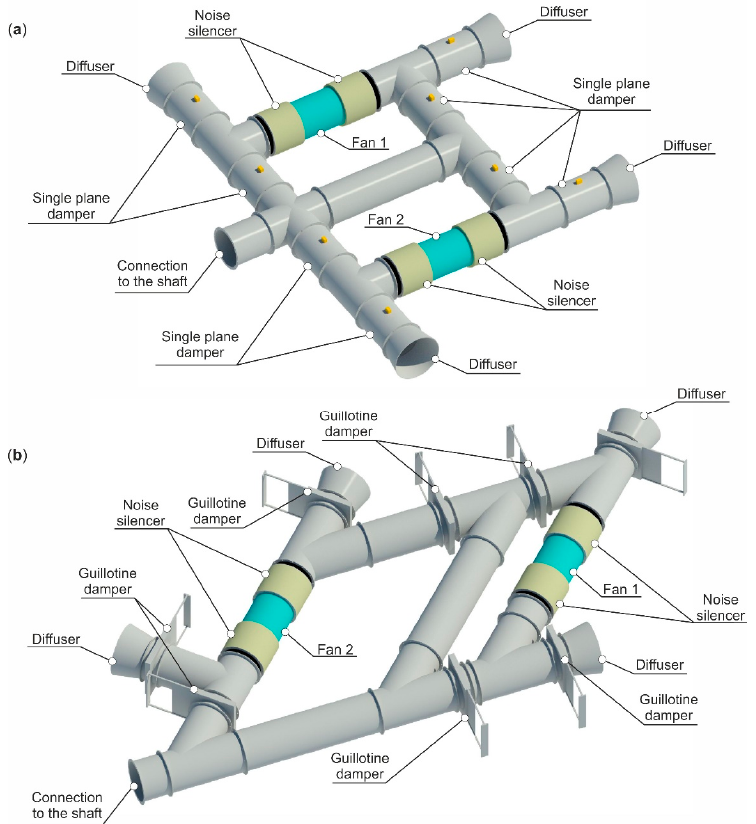
Figure 8. Visualization of a fan station solution. ( a ) Solution no. 1. ( b ) Solution no. 2. The station’s ductwork and the corresponding dampers allow the reversion of venti- lation in the mine. It is possible after changing damper positions. Positions of individual dampers for each fan’s normal and reversing operation are shown for the first solution in Figure 9. In the case of the second solution, the positions of gate valves will be analogous. The main advantage of the presented solution regarding the fan station is the possi- bility of its construction and start-up in the vicinity of the existing upcast shaft without long-term interference in the operation of the main fans being replaced. The station may be built outside the ducts of the working fans, which are to be replaced. It is crucial in decommissioning mining facilities which have only one upcast shaft in the final stage of their existence, and the fans cannot be shut down because the ventilation cannot be inter- rupted. Only at the moment when the station is connected to the duct of one of the main fans is it necessary to switch it off. During this time, the second fan can provide the venti- lation function.